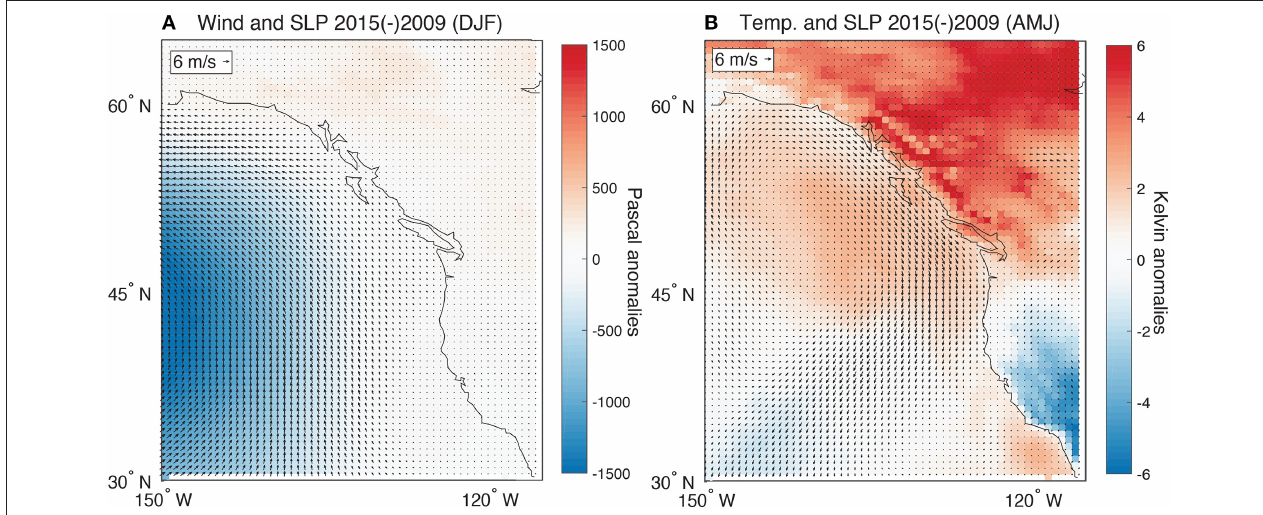
FIGURE 7 | (A) The difference in SLP and 10 m wind fields for DJF between 2015 and 2009. Units for SLP are Pa and the wind vectors are plotted with reference to 6 m s − 1 vector shown in the top left. (B) The 2 m air temperature and 10 m wind fields for AMJ between 2015 and 2009. Units for temperature are K and the wind vectors are plotted with reference to 6 m s − 1 vector shown in the top left. All data were extracted from the MERRA reanalysis database ( Rienecker et al.,